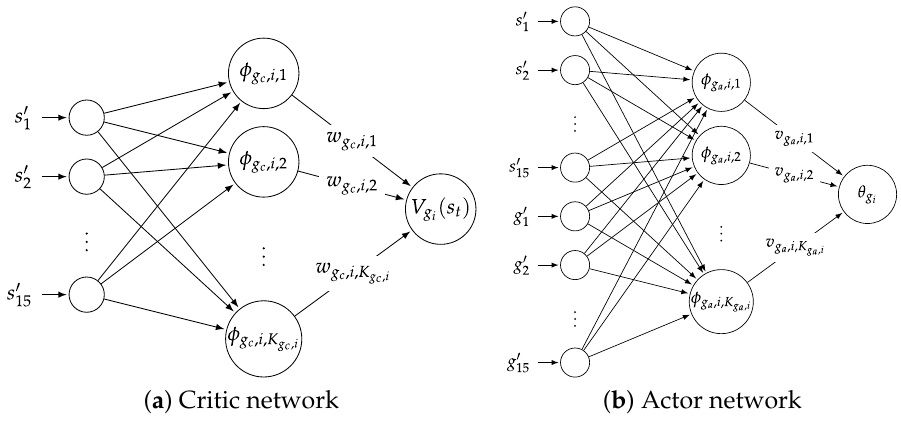
Figure 7. Critic and actor RBF networks for η i , j